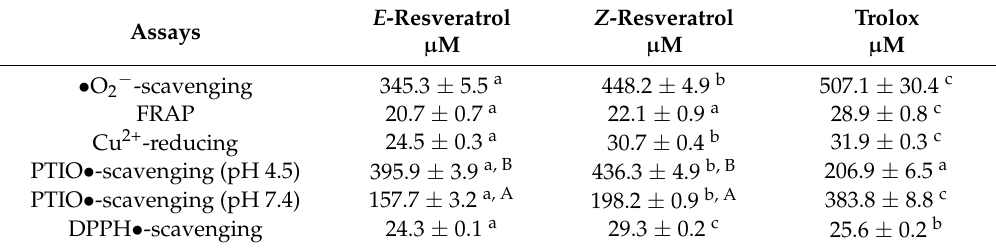
Table 1. The IC 50 values of E -resveratrol and Z -resveratrol in various antioxidant assays.